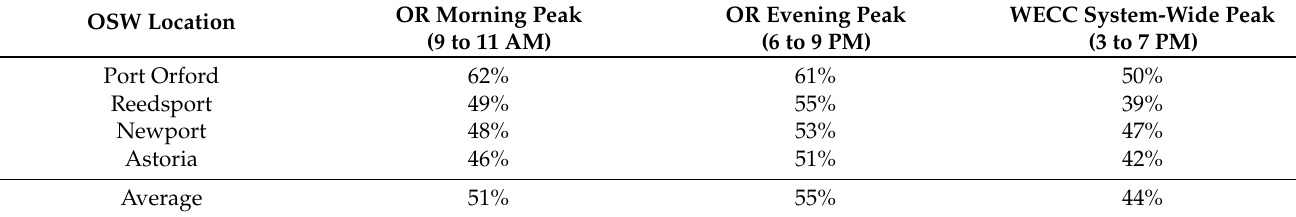
Table 2. OSW generation gross capacity factors during regional and system peak hours, averaged over 2012. OSW